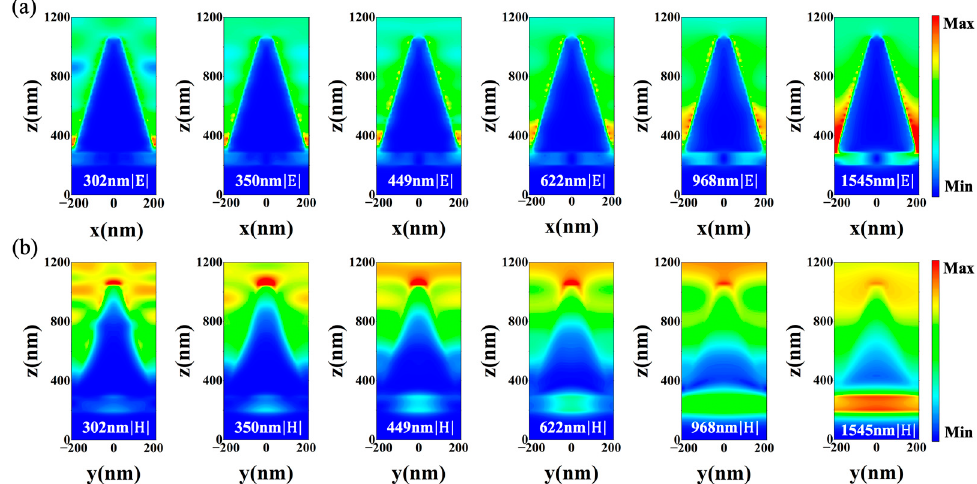
Figure 4. Calculated distributions of the normalized electric field (|E|) and magnetic field (|H|) in the x-z plane and y-z plane at wavelengths of 302 nm, 350 nm, 449 nm, 622 nm, 968 nm and 1545 nm, respectively. ( a ) Electric field in x ‐ z plane. ( b ) Magnetic field in y ‐ z plane. As depicted in Figure 4b, the magnetic field is mainly distributed on the top surface of the truncated cone and the middle MIM structure, and partially distributed on the sidewall surface of the truncated cone. When the electric field drives the electrons to gather in the x - axis direction, the local surface current will form in the y -axis direction, thereby generating magnetic field excitation on the surface, which is MPs [47]. As seen in Figure 4a, plasmon resonance coupling occurs in the upper part of the sidewall of the same cone, shown in Figure 4b. The magnetic field distribution on the top circular plan is comes gradually weaker in the near ‐ infrared region. Moreover, the local surface current also appears on the sidewalls of the truncated cone to form weaker magnetic field excita ‐ tion. It is well known that the electromagnetic field intensity decays exponentially while propagating into materials. The skin depth is 𝛿 (cid:3404) 𝑐 𝜅𝜔⁄ (cid:3404) 𝜆 2𝜋𝜅⁄ , where 𝜅 is the imagi ‐ nary part of the refractive index (i.e., the extinction coefficient). The 𝛿 of tungsten is be ‐ tween 10 and 20 nm, which increases with wavelength [48]. The thickness of the upper layer of tungsten is set to 10 nm in the MIM structure; thus, the short ‐ wavelength light will be reflected on the surface and absorbed by the sidewalls of the truncated cone by multiple scattering, while the long wave will enter the MIM optical resonator structure to generate magnetic field resonance and then be absorbed. Remarkably, there are two sources of long ‐ wavelength photons: one is the photons of the incident light itself, and the other is a few lower ‐ energy photons generated from the damping of the short ‐ wavelength light by multiple scattering along the sidewall of the truncated cone. Consequently, some light enters the MIM structure and generates weak magnetic field resonance, as shown in the magnetic field distribution diagram at 302 nm and 350 nm. As the wavelength in ‐ creases, more and more long ‐ wavelength photons are absorbed in the MIM structure, which can be fully proven by the strong magnetic field distribution at 968 nm and 1545 nm in Figure 4b. Hence, the design of the MIM structure improves the absorption of the absorber in the near ‐ infrared region. In short, the underlying physical mechanisms of the wide ‐ spectrum high absorption of the absorber can be attributed to the excitation of MPs on the surface of tungsten trun ‐ cated cones, the cavity plasmon resonance that can form a light ‐ trapping structure be ‐ tween truncated cones and the magnetic field resonance of MIM optical resonator struc ‐ tures. Additionally, another essential point is that the high ‐ refractive ‐ index imaginary component of metal tungsten shows the strong intrinsic absorption of light, which will be